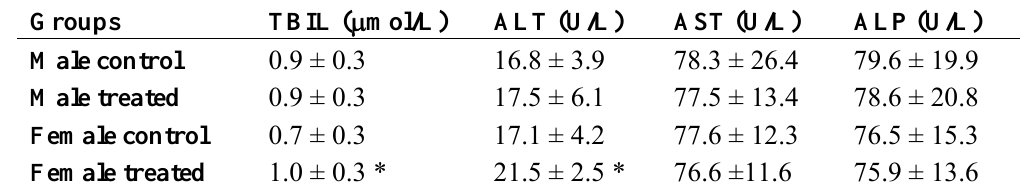
Table 1. Changes of biochemical parameters in the serum of mice induced by L. camara ’s leaf